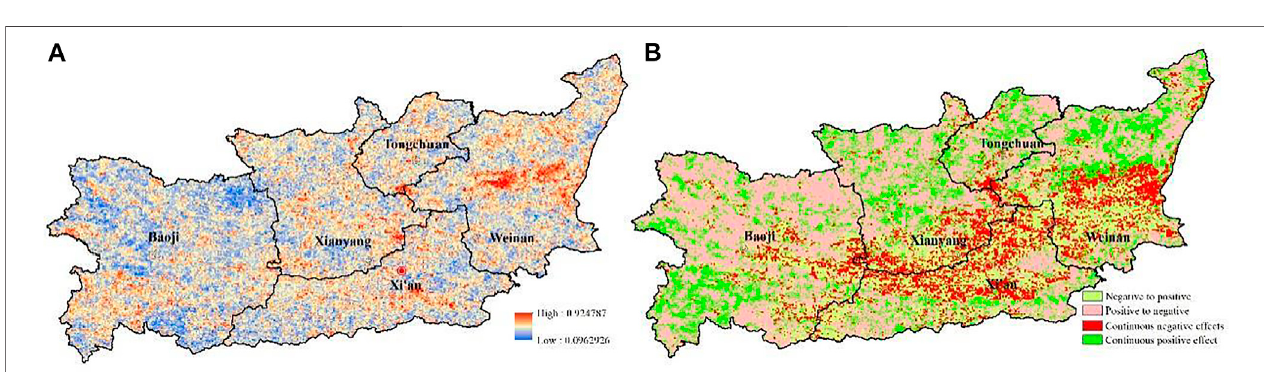
FIGURE 5 | Spatial distributions of anthropogenic effects on vegetation cover in Guanzhong, Central China. (A) Hurst distribution of anthropogenic effects on vegetation cover, (B) future trend in anthropogenic effects on vegetation cover.